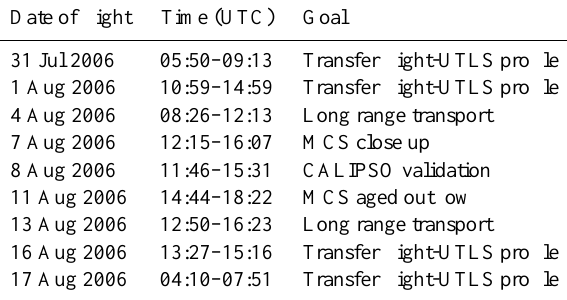
Table 1. Overview of flights during